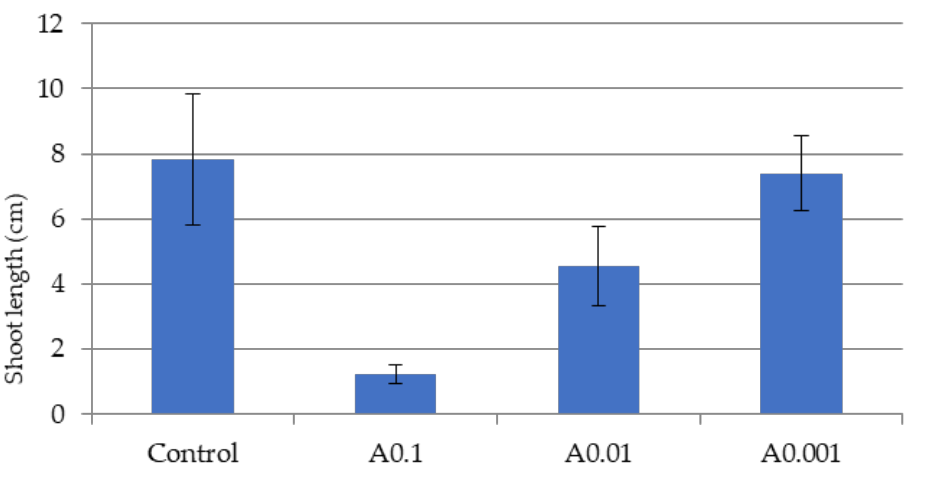
Figure 2. Average shoot length of sorghum plants after 5 days of